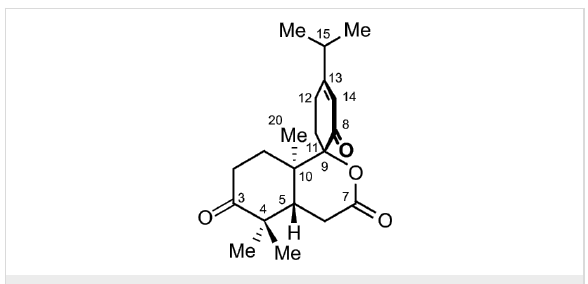
Figure 1: Structure of decandrinin ( 1 ).